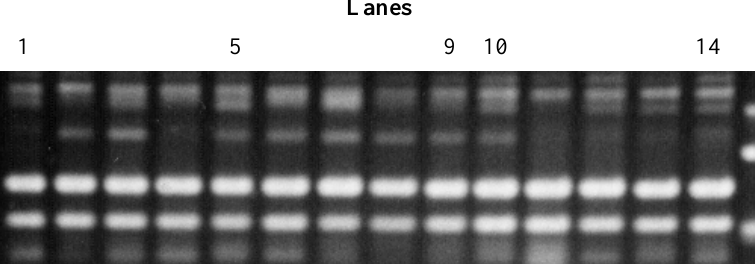
Figure 3 - RAPD pattern produced by the primer OPR03 in the components of resistant and susceptible bulks. The band indicated by the arrow is linked to the Co.5 allele. The band patterns for homozygous resistant plants (lanes 1-9), and homozygous susceptible plants (lanes 10-14) are shown.